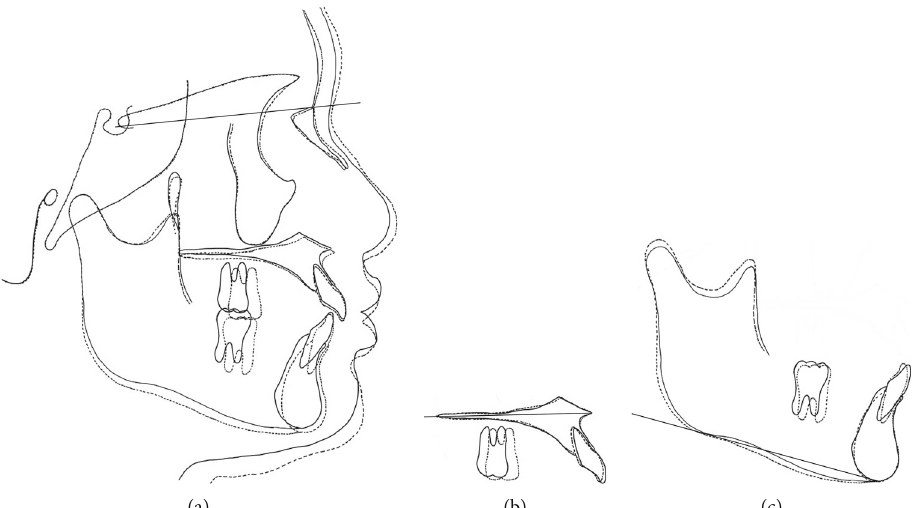
Figure 7: Superimposed tracing of the pretreatment and posttreatment lateral cephalometric radiographs: (a) overall, (b) maxilla, and (c)